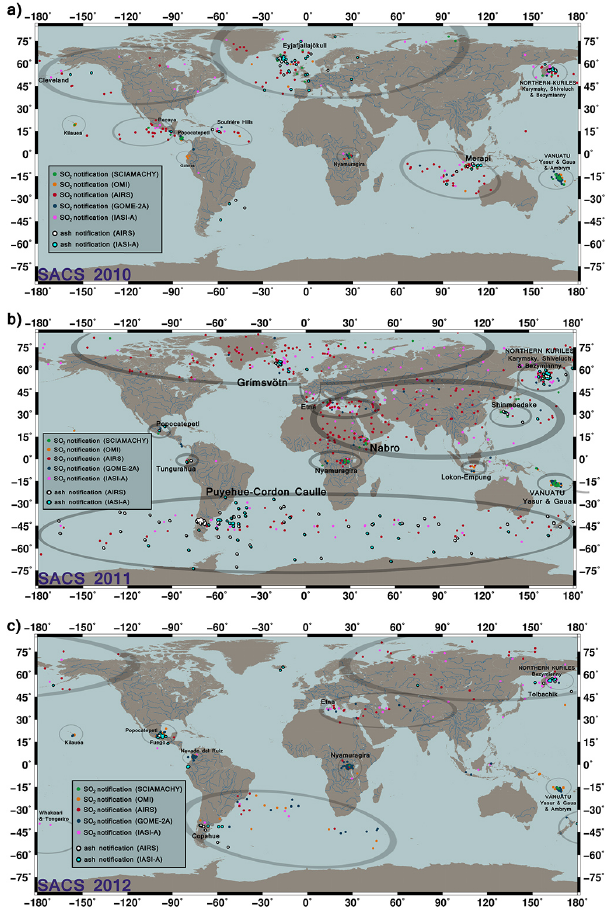
Fig. 18. SACS notifications for 2010, 2011 and